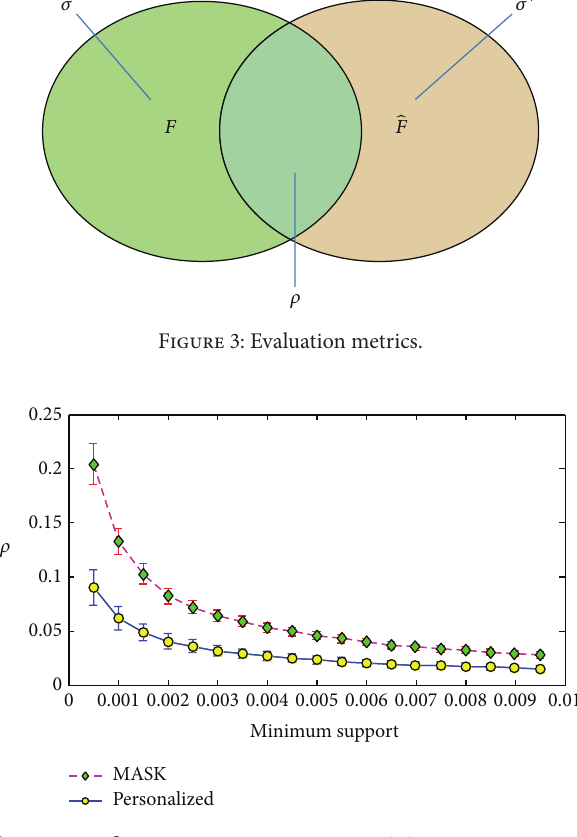
Figure 4: Support error 𝜌 versus minimum support on T3.I4.D500K.N10.